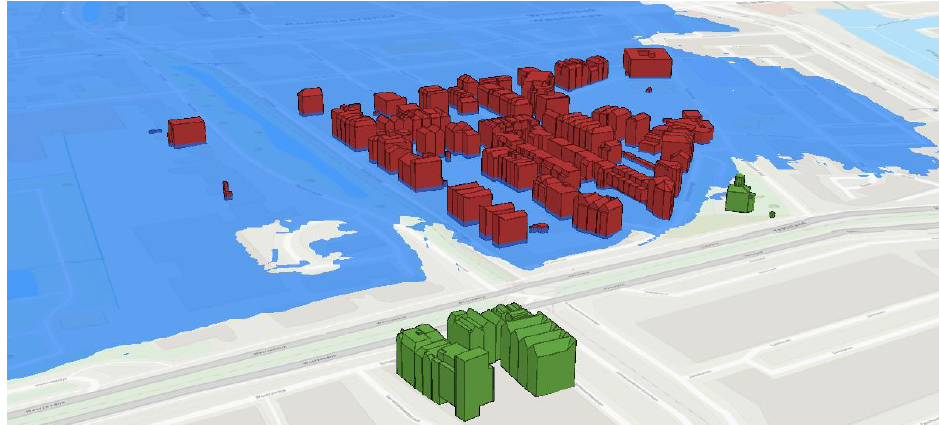
Figure 7. 3D Flood